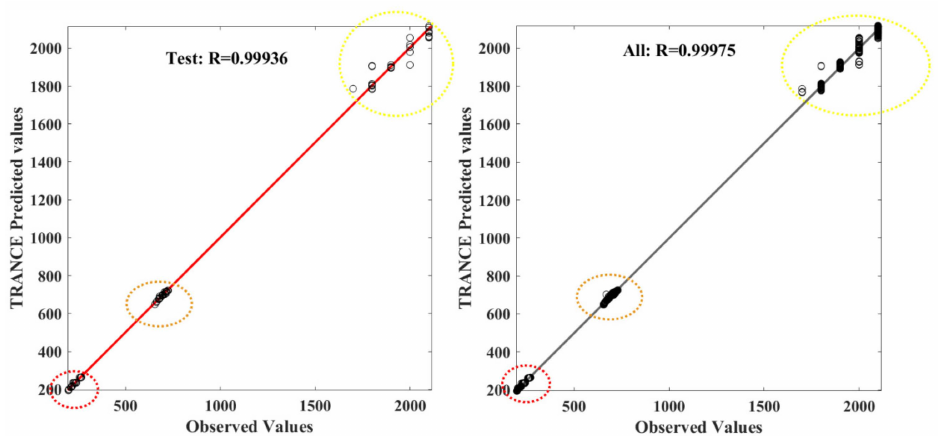
Figure 11. The correlation coefficient for three threat zone prediction values from the TRANCE model in testing and all